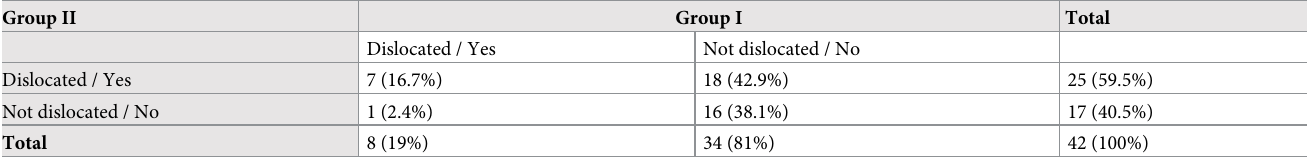
Table 6. Contingency table for variable “dislocation” grouped by Group I & II. Group II